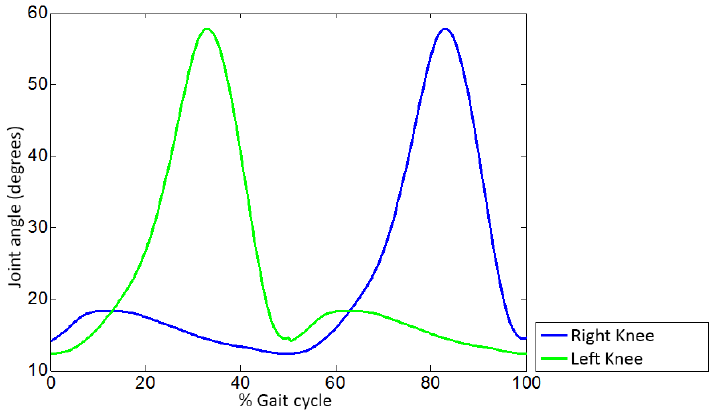
Figure 7. Gait pattern